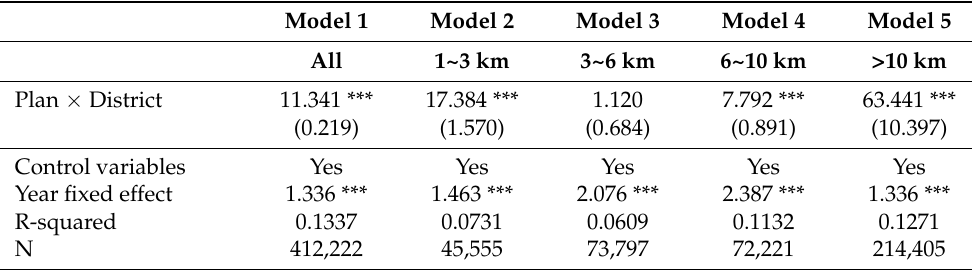
Table 7. Impact of the construction of the National Big Data (Guizhou) Experimental Area on residential area